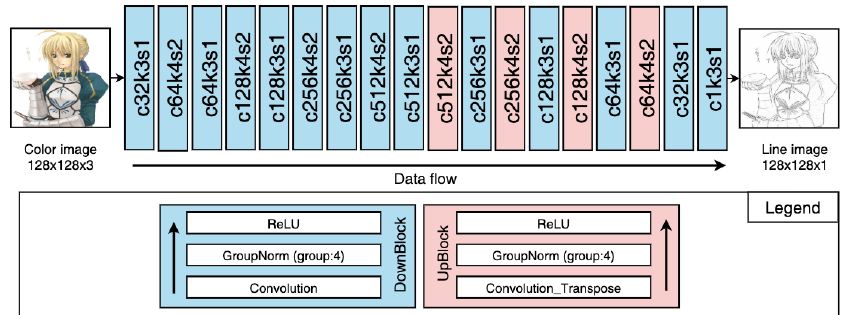
Figure 6. Line Detection Model (c: output filter number, k: kernel Size, s: stride, For example, c32k3s1 means inter convolution layer output filter number is 32, kernel size is 3, and stride is